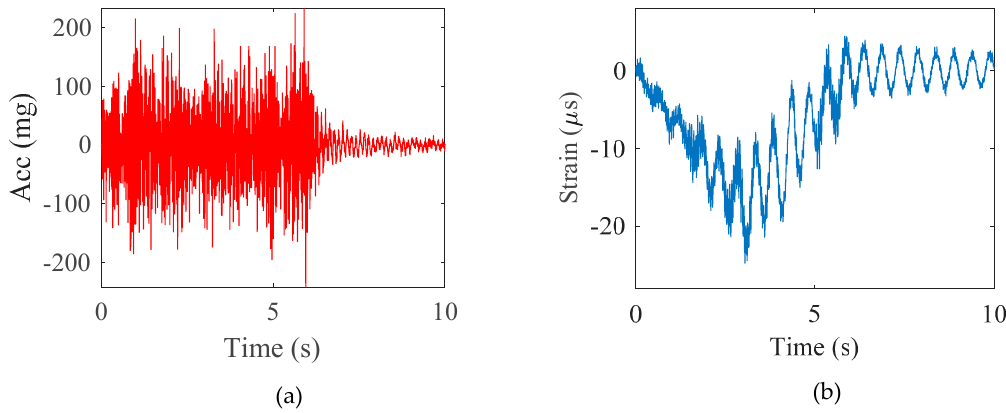
Figure 4. Numerical validation: ( a ) acceleration response and ( b ) strain response.